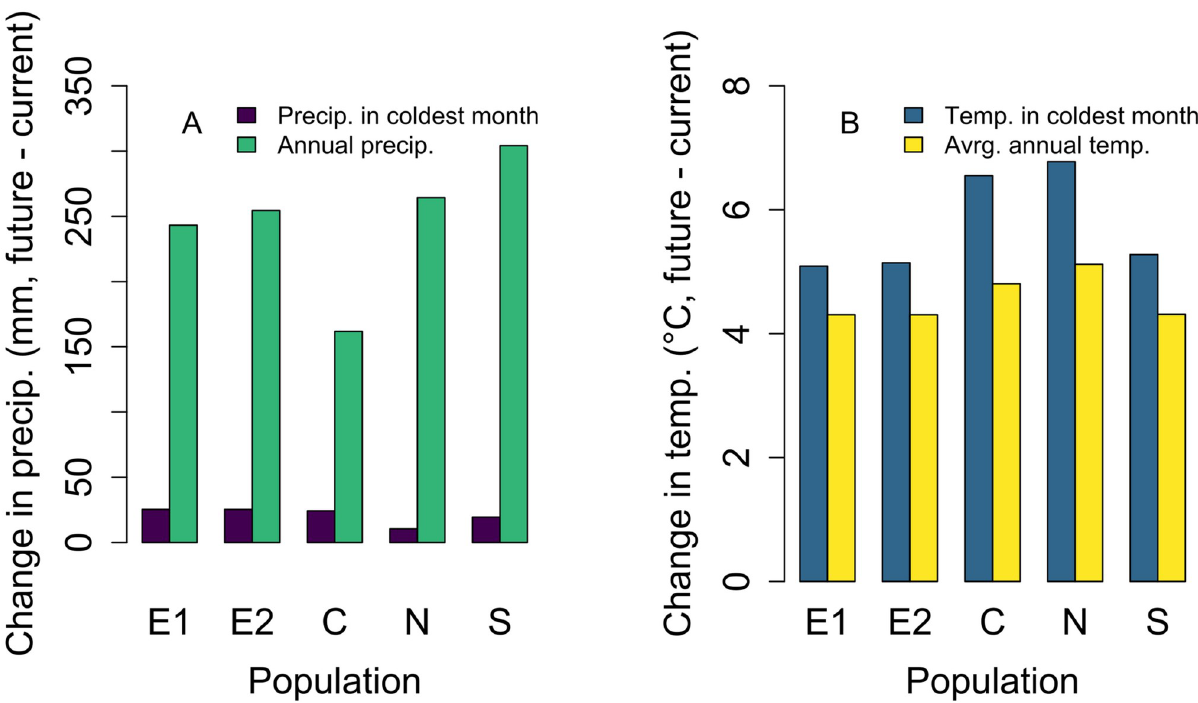
Fig 4. Rate of climate change. Change (mean future, 2086–2100, minus mean current, 2008–2022) in precipitation (A) and temperature (B) conditions for five populations for each climate driver present in the vital rate functions. Populations are arranged along the x-axis by increasing current average annual temperature; for example, the E1 population has the coldest average annual temperature over the current period, and the S population has the warmest average annual temperature over this period. See S1 Table in S1 Appendix for raw data.